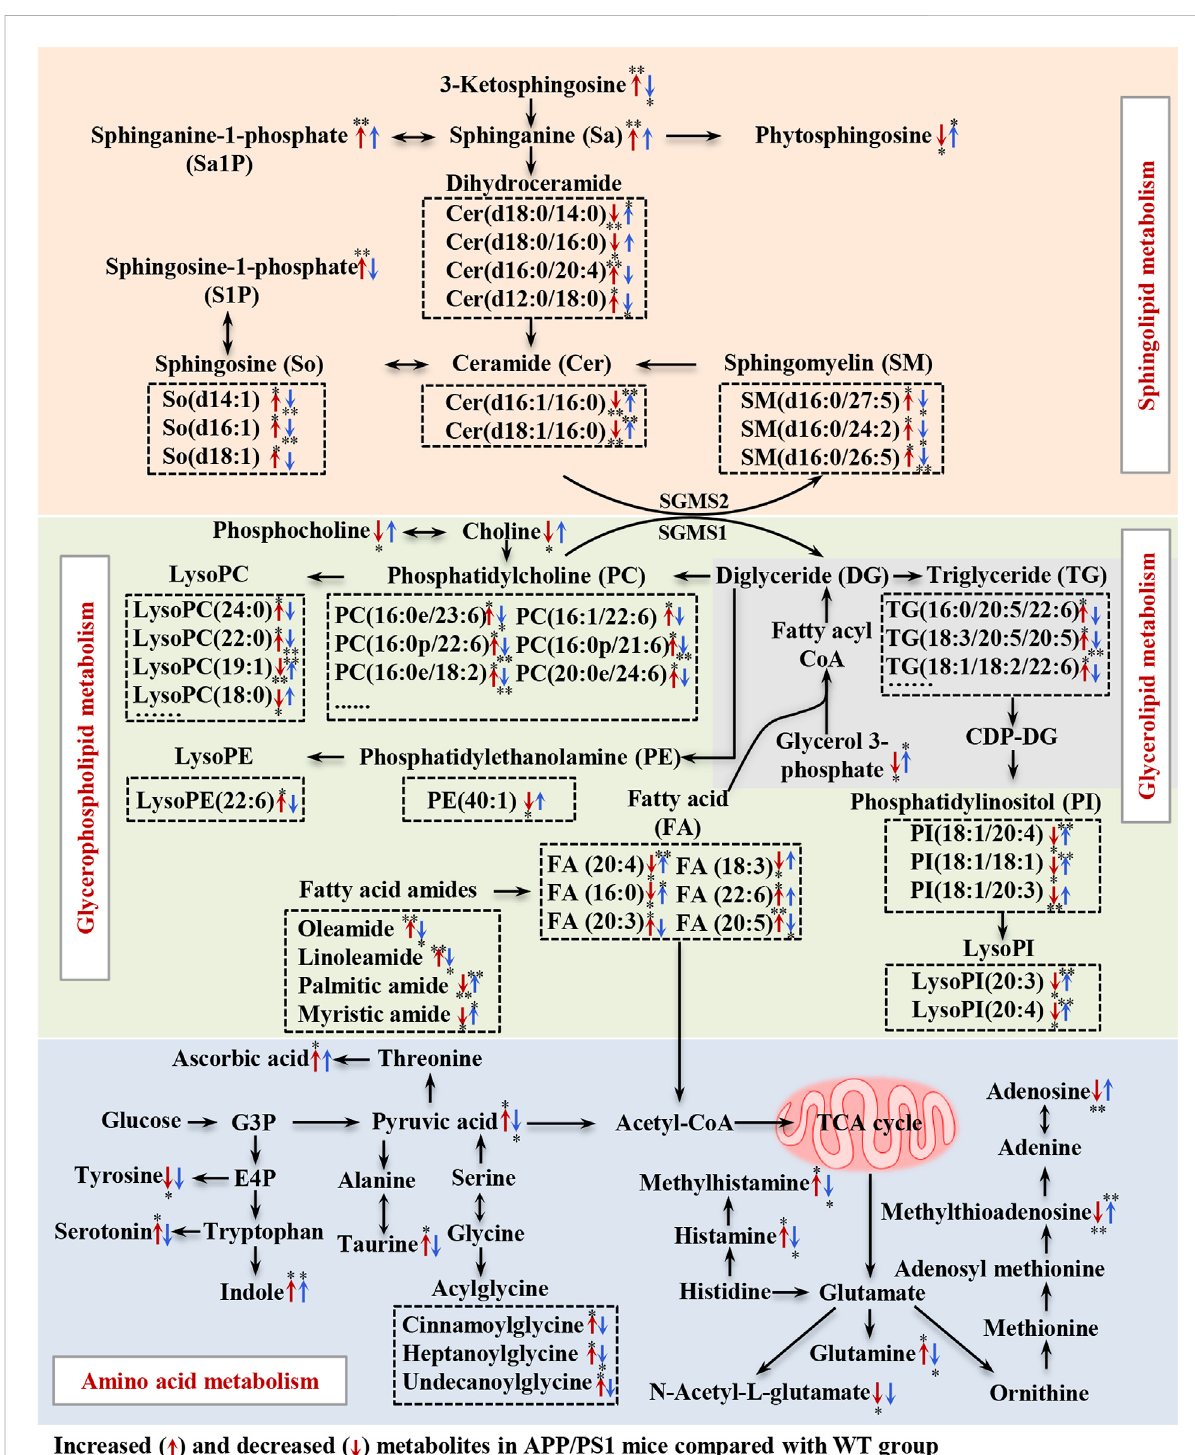
DisturbedmetabolicpathwaynetworkinAPP/PS1miceandtheinterventionaleffectsofGBLEbyintegratingmetabolomicsandlipidomicsdata. TheredarrowsrepresentalteredmetabolitesinAPP/PS1micecomparedwithWTgroup,andthebluearrowsrepresenttheregulatedmetabolitesby GBLE treatment. *: adjusted- p < 0.05, **: adjusted- p <